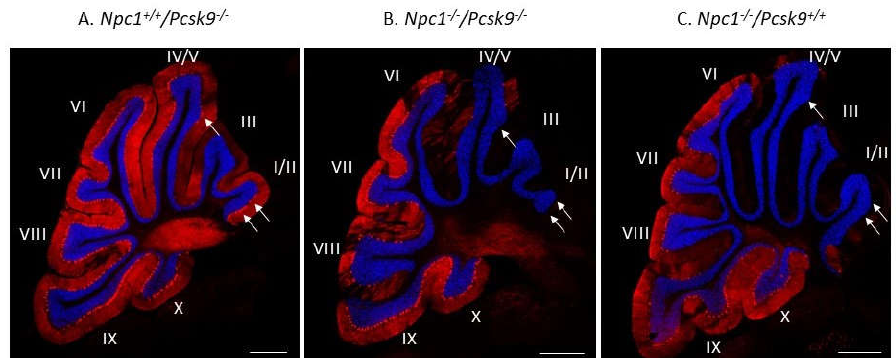
Figure 4. Purkinje cell loss in Pcsk9 - / - mice in the context of NPC1 disease. Cerebellar sections from 7-week old Pcsk9 - / - / Npc1 +/+ ( A ), Pcsk9 - / - / Npc1 - / - ( B ) and Pcsk9 +/+ / Npc1 - / - ( C ) mice were analyzed by indirect immunohistochemical staining. Purkinje neurons were stained for calbindin (red) and counterstained with DAPI (blue) to distinguish the granule cell layer from the molecular layer. In Pcsk9 - / - / Npc1 +/+ sections ( A ), Purkinje neurons were found generally in all lobules and especially in lobule I / II. In Pcsk9 - / - / Npc1 - / - ( B ) and Pcsk9 +/+ / Npc1 - / - ( C ) sections, a marked decrease of calbindin staining in the anterior lobules (I-IV / V) indicated Purkinje neuron death consistent with the level of NPC1 disease at this age. No obvious di ff erence was observed in the calbindin staining pattern between Pcsk9 - / - / Npc1 - / - and Pcsk9 +/+ / Npc1 - / - mice, suggesting that deletion of Pcsk9 does not appear to alter Purkinje cell death progression in the context of NPC1 disease. Bar = 200 µ m. Arrows point to Purkinje neuron cell bodies in panel A, and their absence in panels B, C.